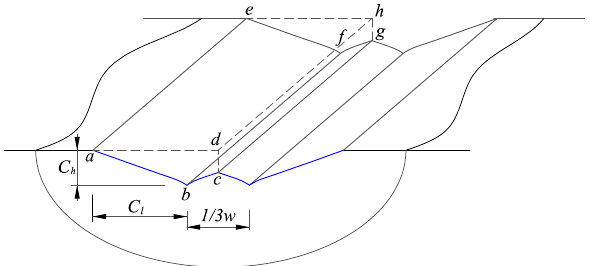
Figure 8. Illustration of the theoretical material removal volume of a single-diamond